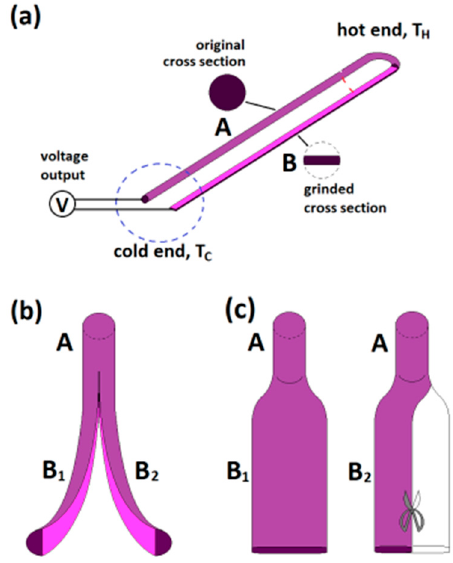
Figure 1. Schematic figures for the sample preparation: ( a ) A “Type U” sample made from one piece of thick wire, where one arm (marked “ A ”) is in its original round cross-section shape and the other one (marked “ B ”) is mechanically thinned to have a thickness of ¼–½ of the original diameter; ( b ) A split sample, which is always made from one piece of thick W wire; ( c ) A pressed sample, where the arm “ B 1 ” is mechanically pressed to be much thinner than the diameter of the original wire “ A ”, and the thin arm “ B 1 ” of such a sample could be further cut into narrower arm “ B 2 ” for a second run measurement.